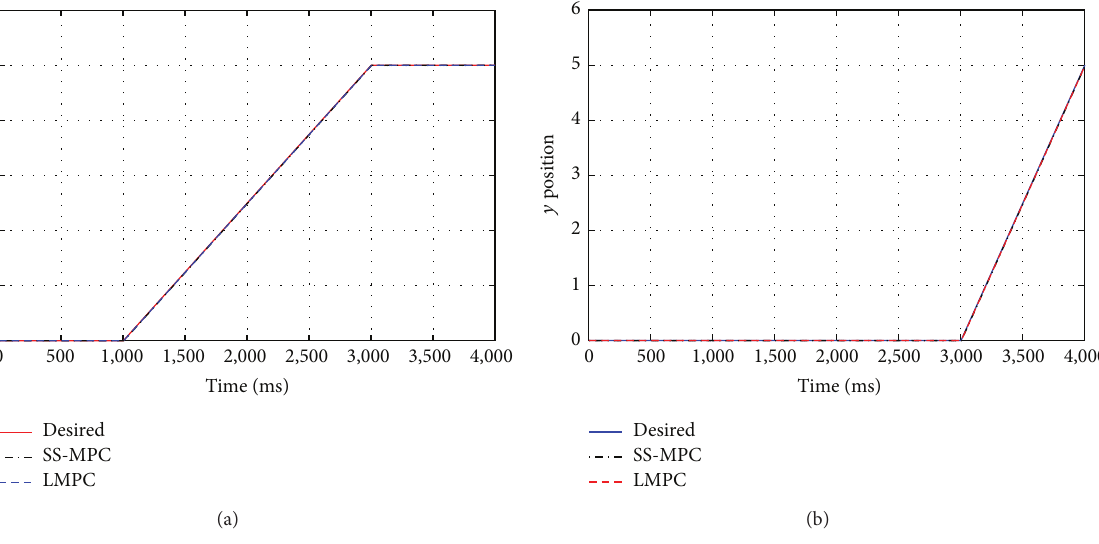
Figure 6: Tracking 𝑥 (a) and 𝑦 in (b).